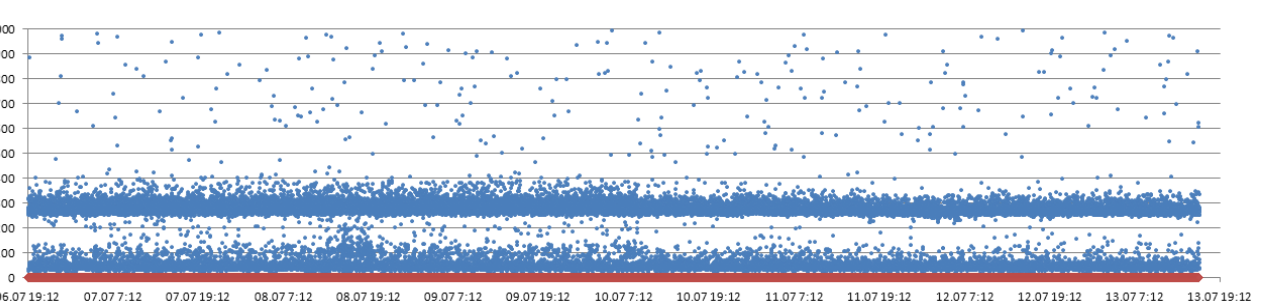
Fig. 4. RTT of BITE 4G cellular network operator subsystem, ms.